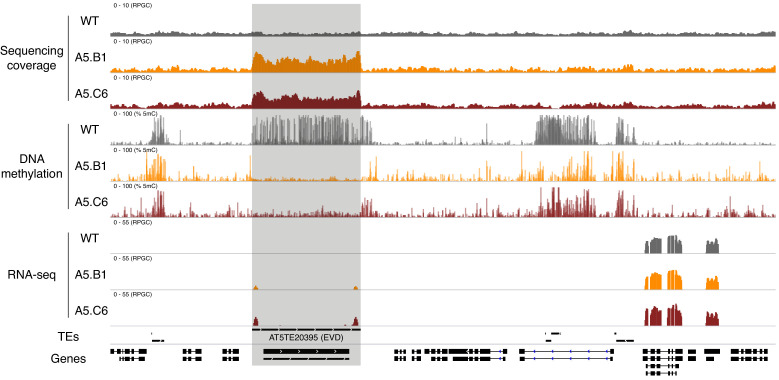
Deregulation of EVD transposon in epiERs.Genome browser view showing normalised sequencing coverage (RPGC), DNA methylation rate (%) and RNA-seq (RPGC) in wild-type (WT) and progenies from epiERs A5.B1 and A5.C6. Grey box, AT2TE20395 (EVD).